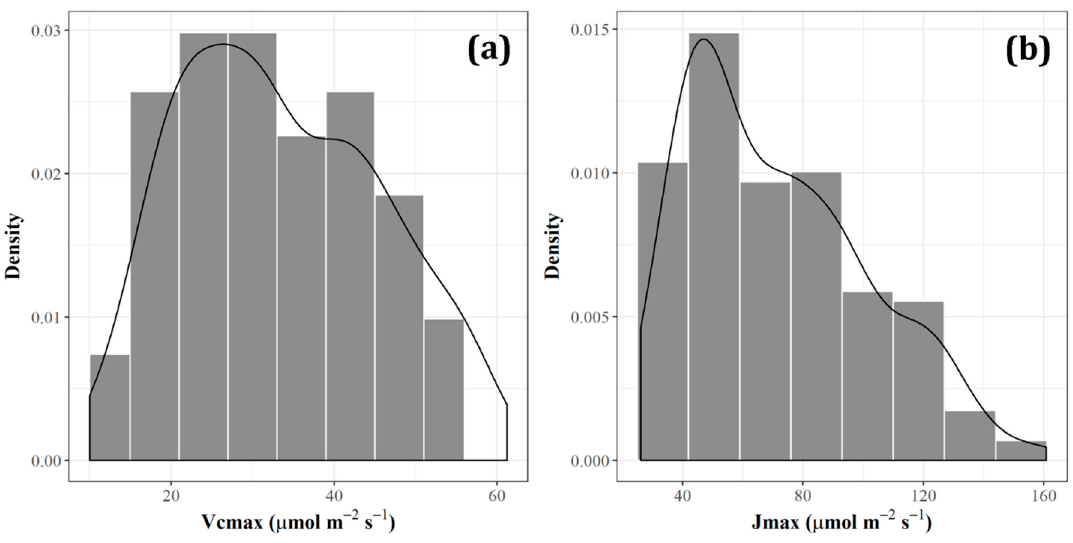
Figure 2. Distribution of photosynthetic parameters: ( a ) the maximum rate of carboxylation (V cmax ), and ( b ) the maximum rate of electron transport (J max ).